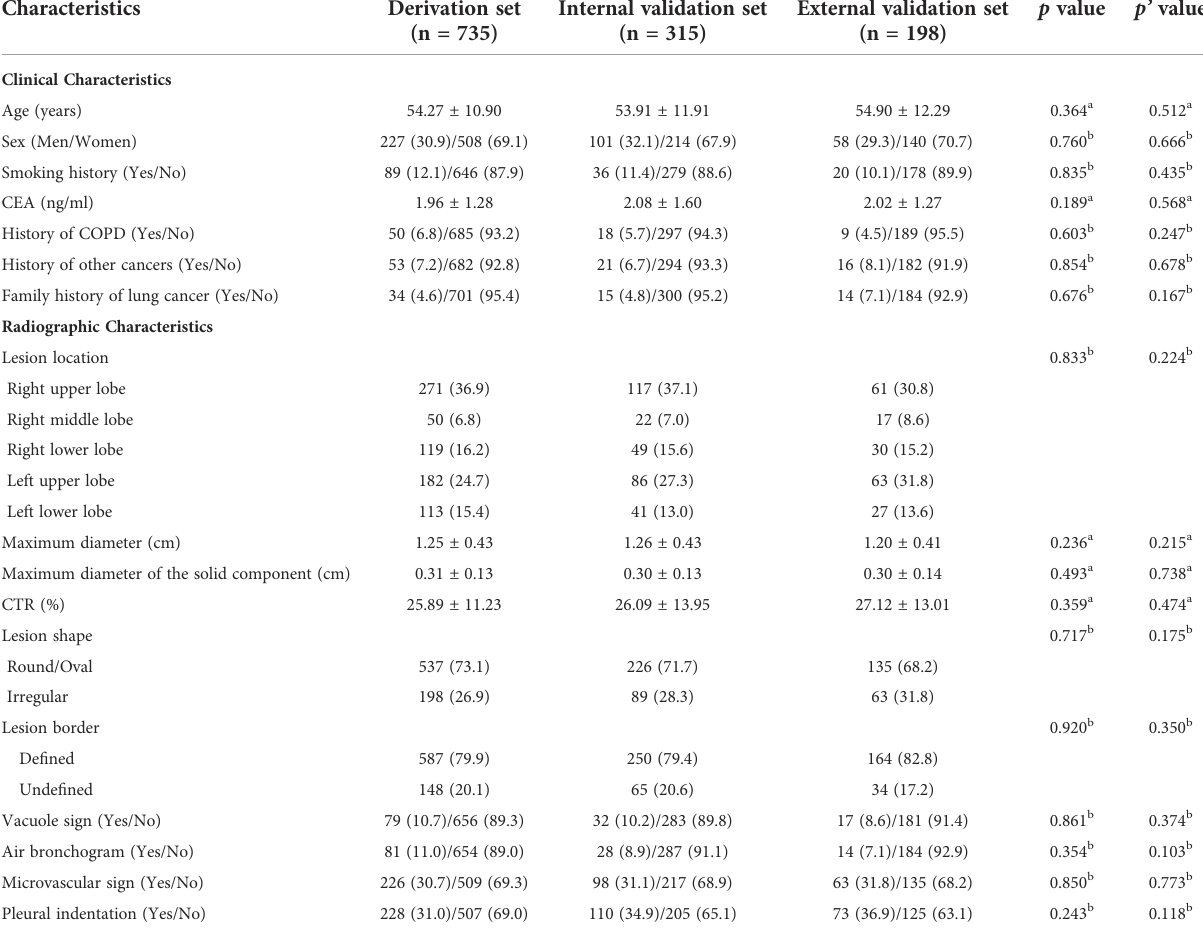
TABLE 1 Comparison of clinical and radiographic characteristics between derivation and internal/external validation sets.